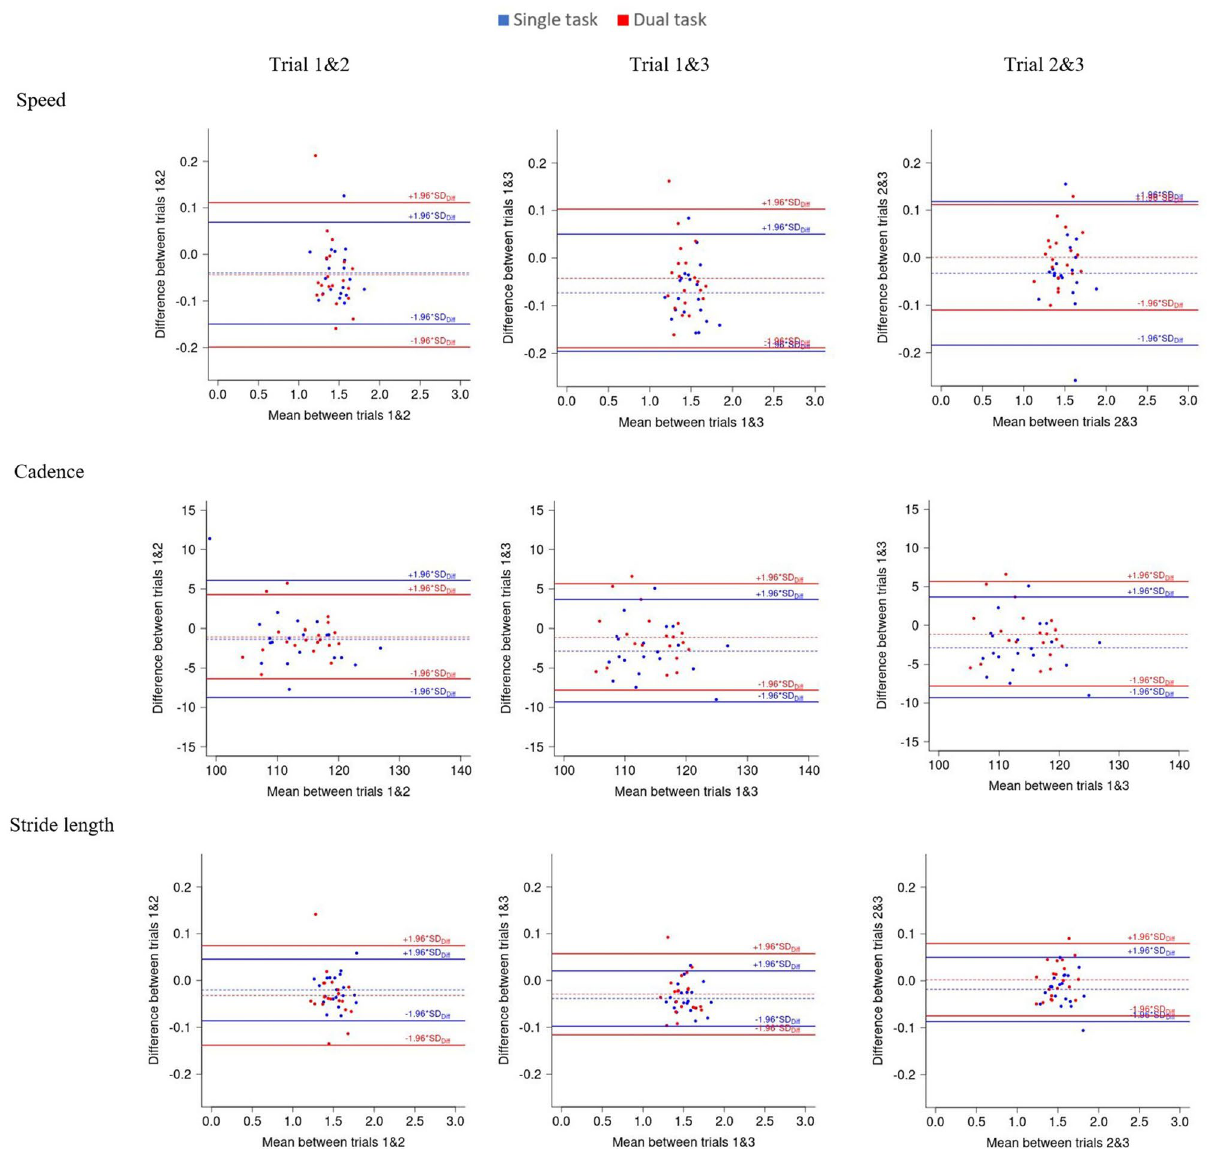
Figure 2. Bland and Altman plots for speed, stride length and cadence in single task (blue) and dual task (red) and for speed, stride length and cadence for trial 1 and 2, 1 and 3 and 2 and